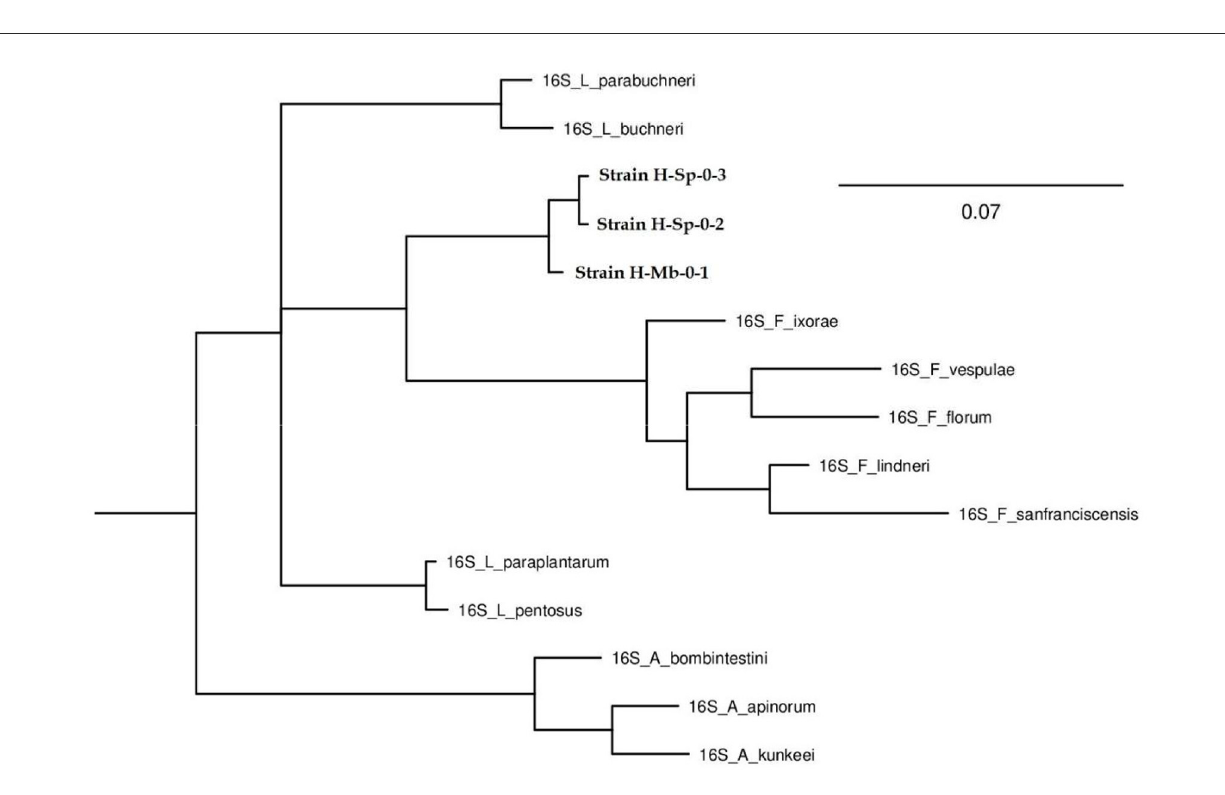
citreum and two undetermined LAB) at the same time and place, from the same beehives of the same bee species, with the only difference that the honey sample was taken from the honey stomach of stingless bees and not from the honey of the